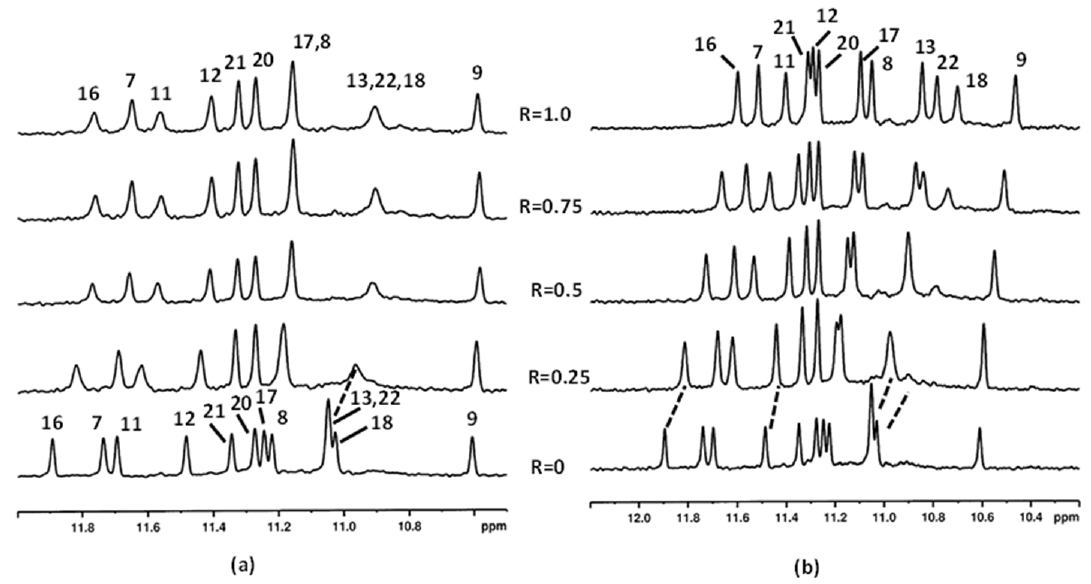
Figure 4. Imino protons region of the 1 H NMR titration spectra of Pu22T14T23 with ( a ) aloe emodin ( 1 ) and ( b ) aloe emodin-8-glucoside ( 2 ).